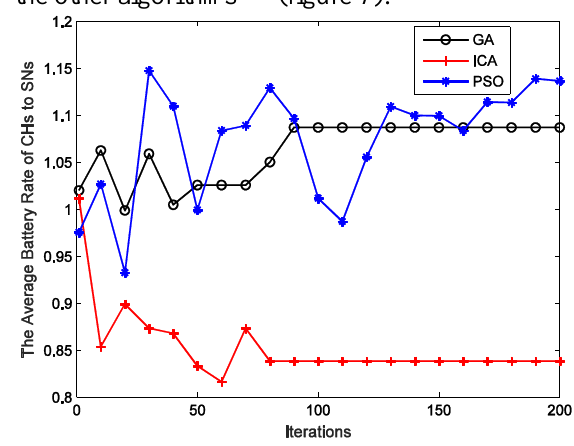
Figure 8. Average battery rate of CHs to